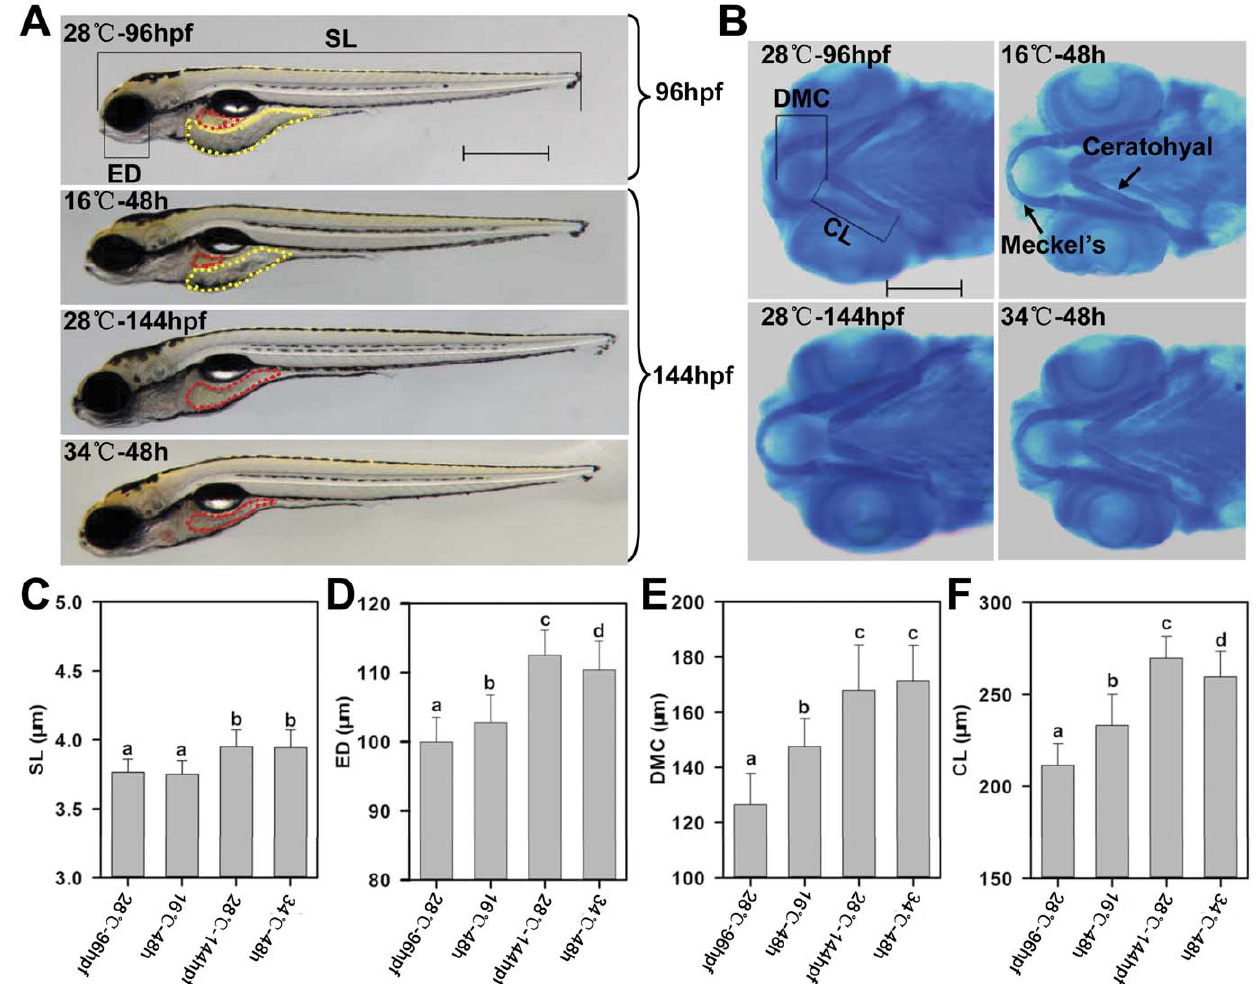
Figure 2. Effects of temperature stress on the development of zebrafish larvae. ( A ) Representative images of zebrafish larvae before and after temperature stress. Zebrafish larvae at 96 hpf (maintained at 28 u C from fertilization) were exposed to temperature stress for 48 h (cultured at 16, 28 or 34 u C from 96 to 144 hpf). Images were taken under a stereomicroscope from Zeiss with a color CCD camera. Red and yellow dashed line indicates intestine lumen and yolk sac, respectively. SL: standard length (distance from the snout to the posterior tip of the notochord). ED: eye diameter. Scale bar: 500 m m. ( B ) Alcian blue staining of the cartilages of jaw and branchial arches. DMC: distance from the inner border of Meckel’s cartilage to the anterior end of ceratohyal. CL: ceratohyal length. Scale bar: 200 m m. ( C, D, E and F ) Bar charts demonstrate the effect of temperature stress on the SL, ED, DMC and CL, respectively. Horizontal axis indicates treatments described in ( A ) and ( B ). Error bars indicate standard deviations (n=40–60). Different letters above the error bars indicate statistically significant differences determined by one-way analysis of variance (ANOVA) followed by Duncan’s multiple range test ( p , 0.05).